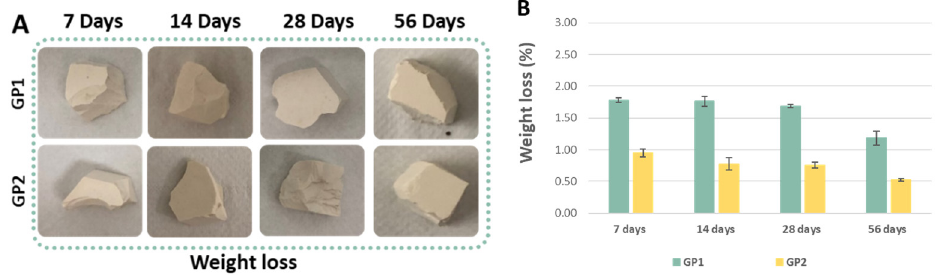
Figure 10. ( A ) GP1 and GP2 images after the weight loss tests. ( B ) GP1 and GP2 weight loss (%) for different ageing times.